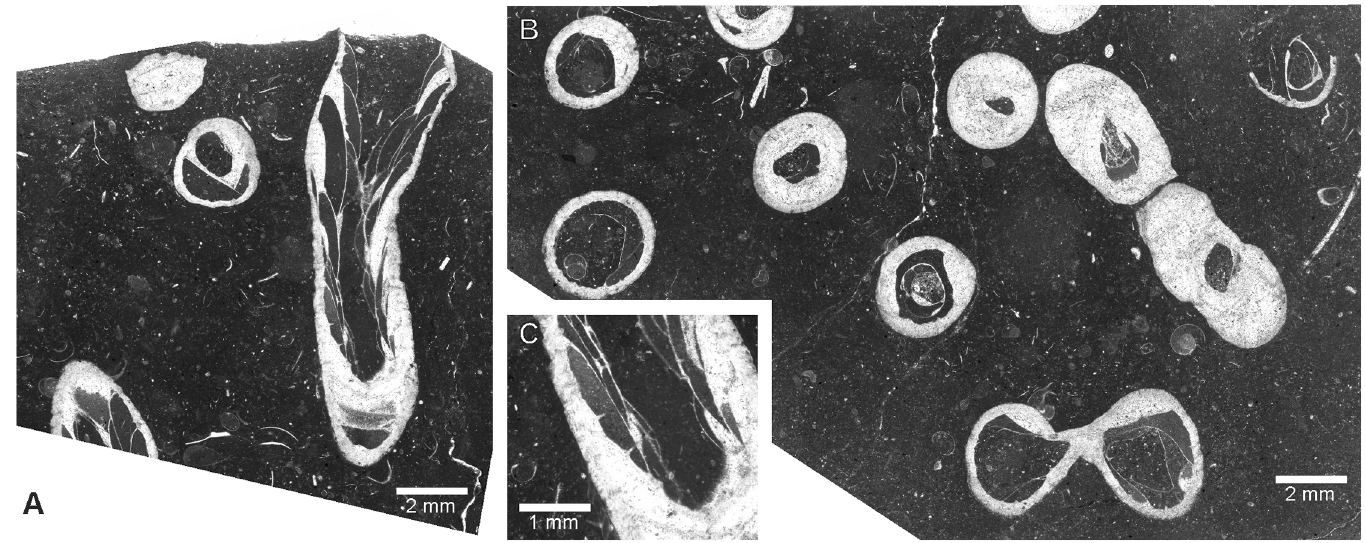
Fig 14. Aulocystis sp. from Kowala Quarry, lithological set L, Upper Famennian. (A) Longitudinal section. (B) Detail of the longitudinal section, specimen shown on (A), notice septal and tabular spines. (C) Transverse section. Specimen GIUS 3619 KF 007.